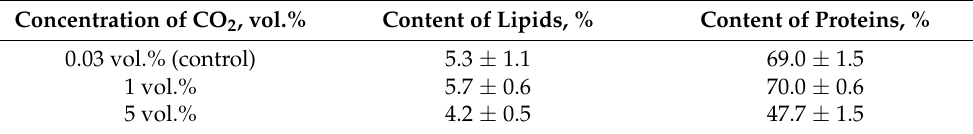
Table 2. Lipid and protein concentration in A. platensis biomass grown at different of CO 2 concentrations. Concentration of CO 2 ,